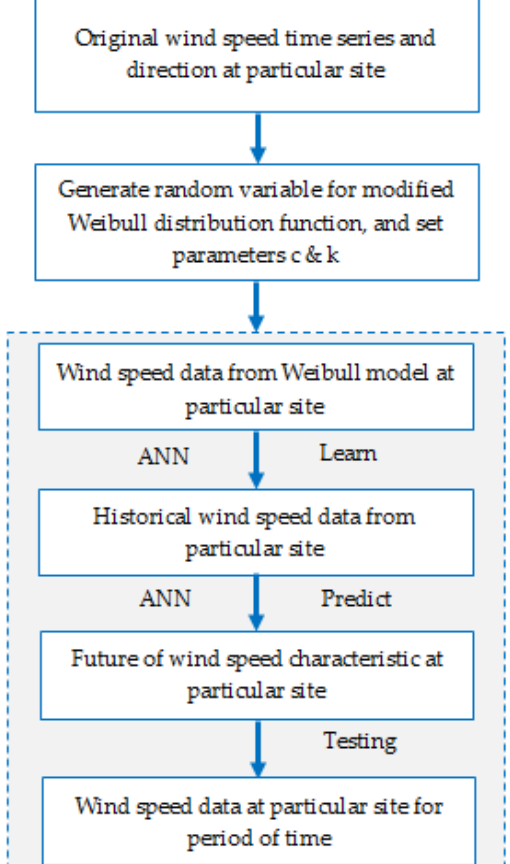
Figure 3. Flowchart of the hybrid model for wind speed prediction.